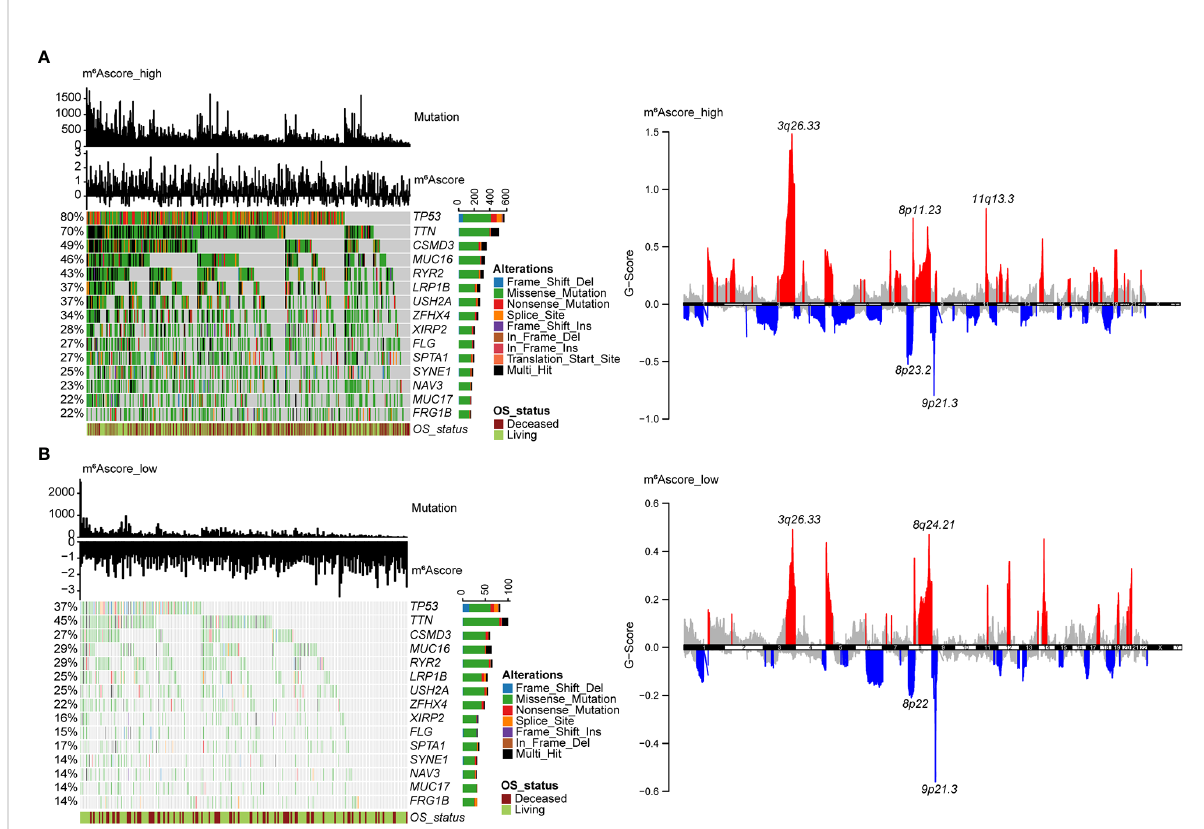
FIGURE 6 Molecular features of m 6 Ascore groups in TCGA datasets. (A) The distribution of tumor somatic mutations in NSCLC with a high m 6 Ascore is depicted in the waterfall plot. Each column represents a patient. TMB is depicted in the upper barplot, and each gene ’ s mutation frequency is indicated by the number on the left. The horizontal barplot on the right depicts the percentage of each variant type, and overall survival status is shown as patient annotations (left). GISTIC plot depicts the distribution of somatic copy number alterations in NSCLC with a high m 6 Ascore, regions of copy number ampli fi cation are highlighted in red, and regions of copy number deletion are highlighted in blue. Several signi fi cant gene names are marked (right). (B) The waterfall plot displays the somatic mutation distribution (left), and the GISTIC plot shows the distribution of somatic copy number alterations (right) in NSCLC with a low m 6